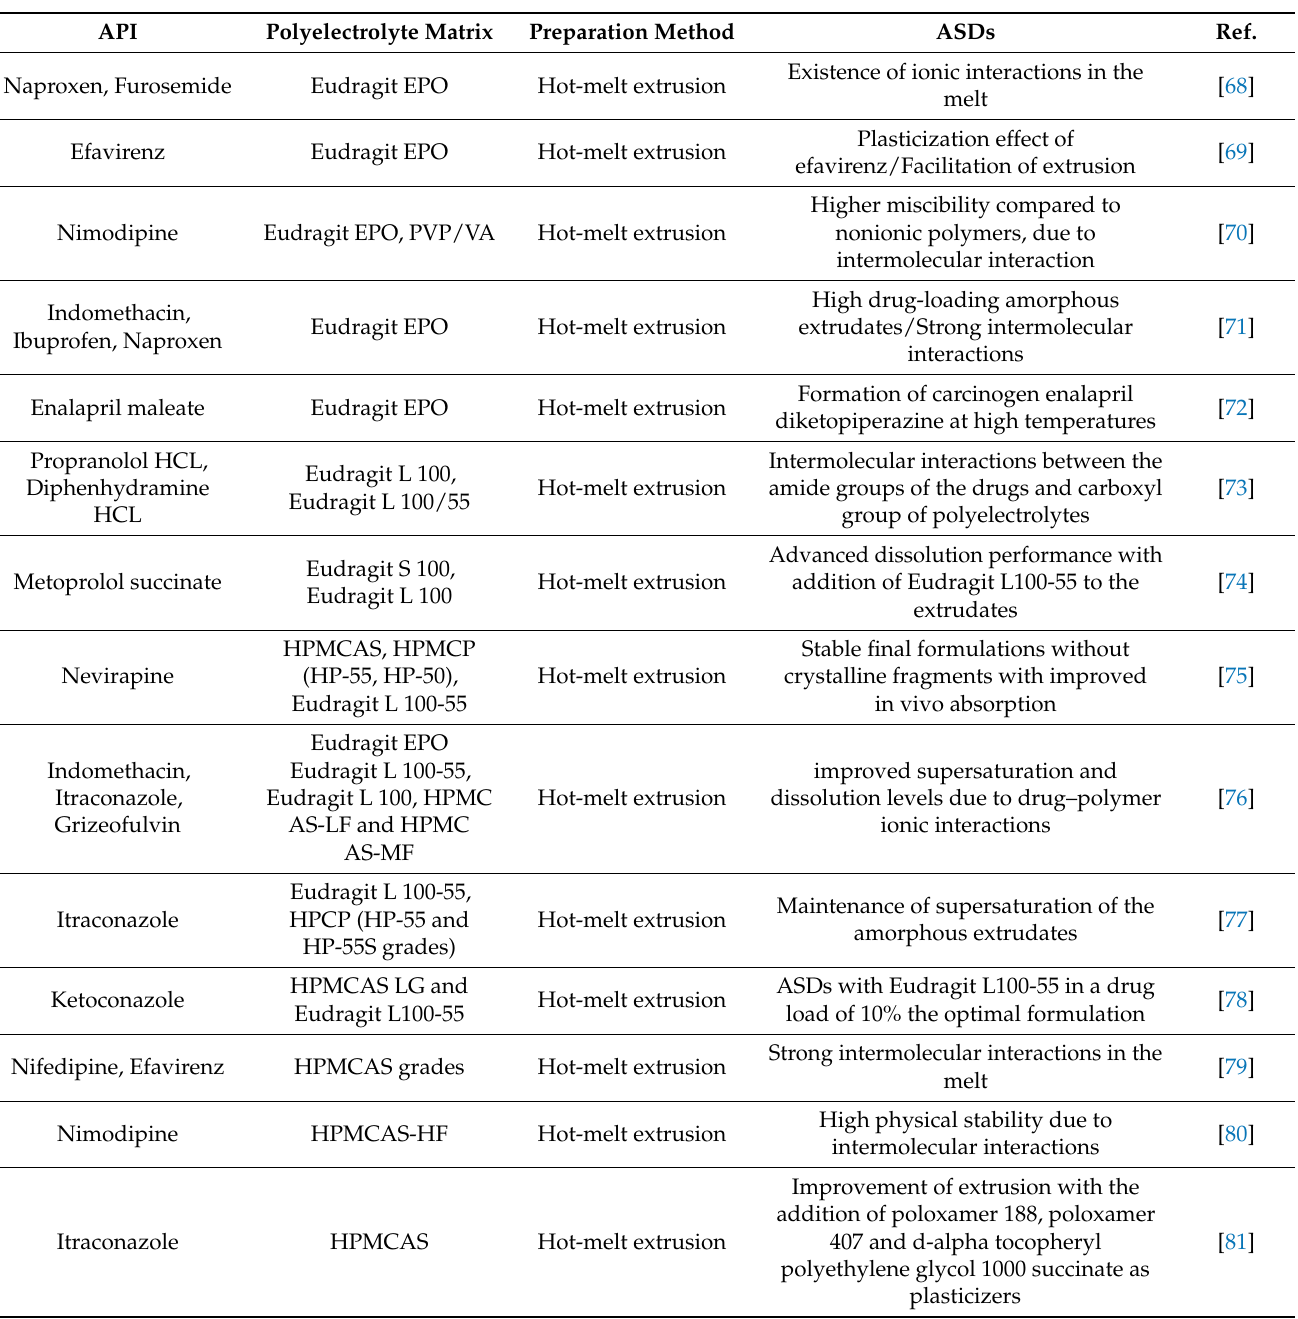
Table 1. Use of polyelectrolytes in